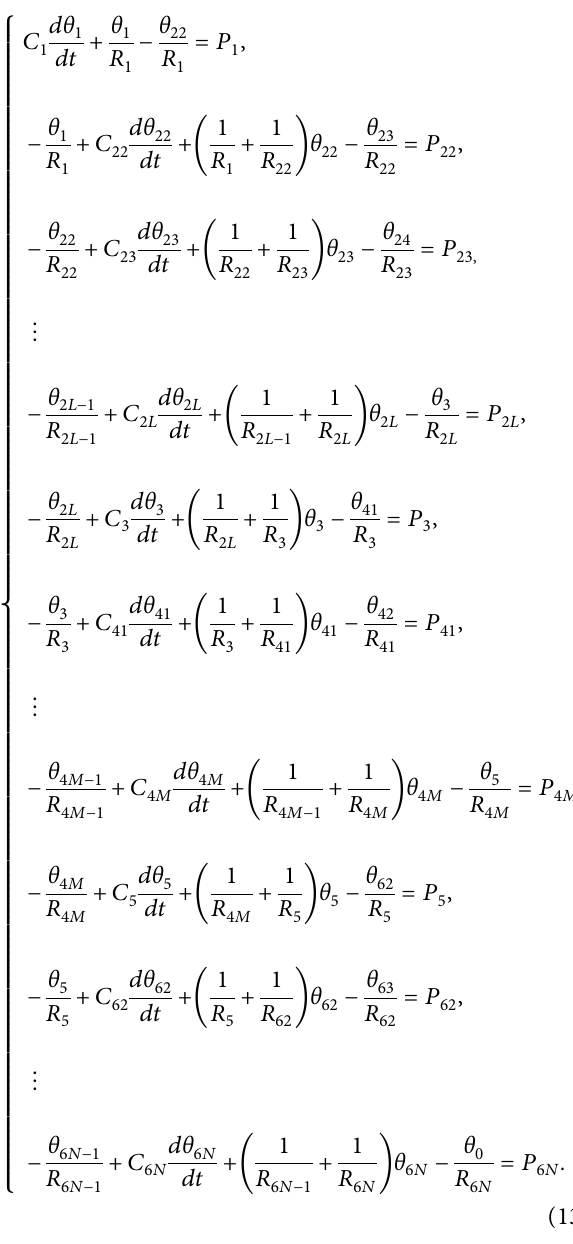
In (13), t indicates time; the other variables are shown in Figure 9. The equation is converted into matrix, and the cable core temperature is calculated using the same method as in